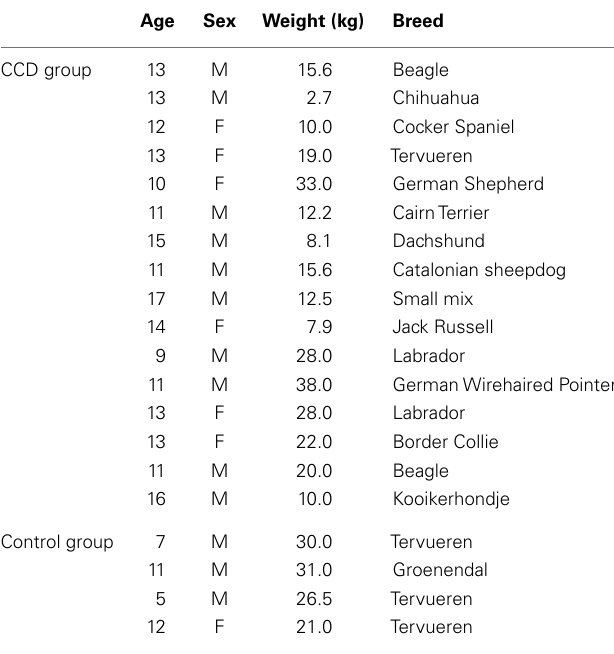
Table 1 | Information regarding age, sex, weight, and breed for the study population